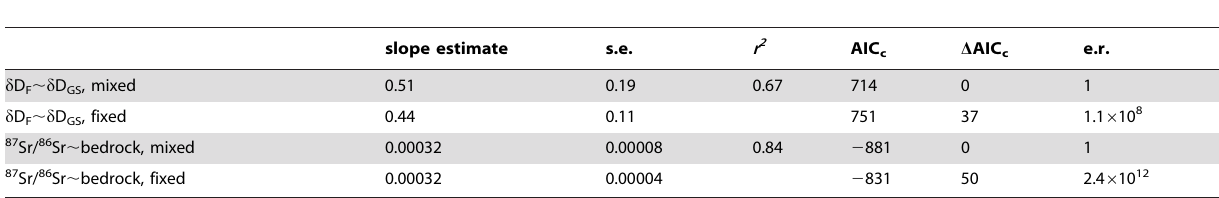
Table 1. Results from the generalized linear mixed effects models (GLMM) used to examine the mechanisms influencing d D F and 87 Sr/ 86 Sr F .